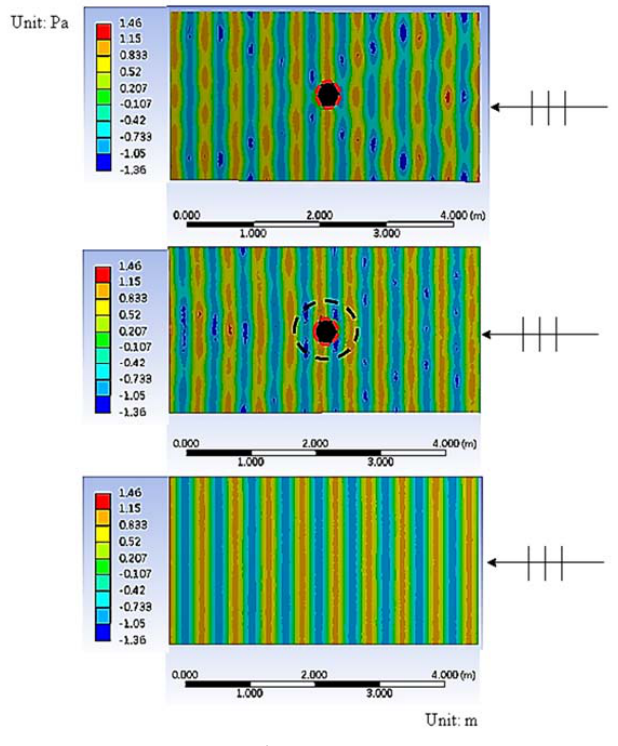
Figure 12. Wave field of uncloaked object (upper plot), cloaked object (middle plot), and free field at 800 Hz. Plane waves with a specific frequency propagate from right to left. The dotted lines indicate the geometry of the cloaked object and cloak shell.